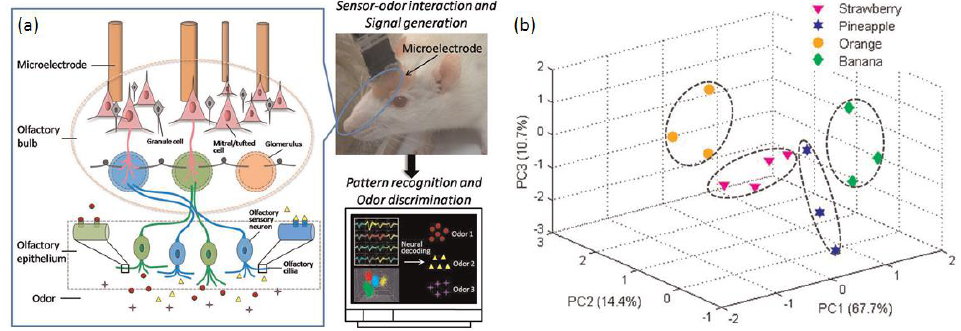
Figure 8. ( a ) Schematic diagram showing the configuration of electronic nose based on in vivo biosensing approaches; ( b ) The result of PCA on recorded data [122].